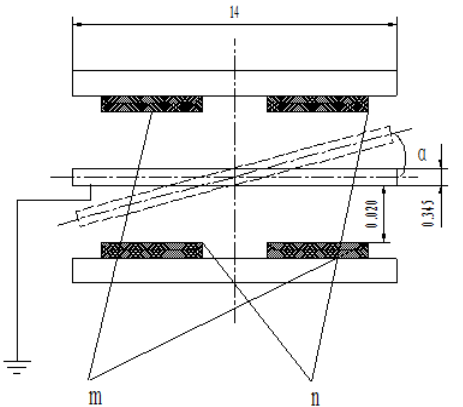
Figure 4. Detection